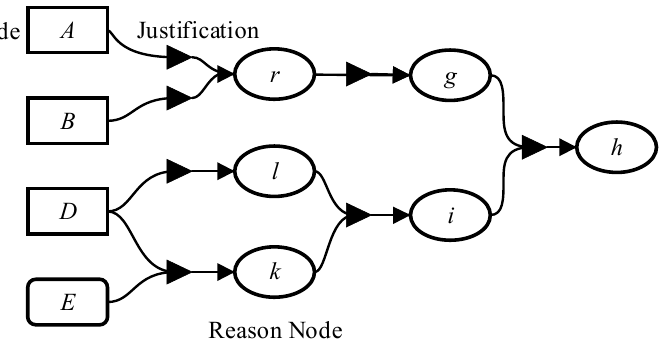
Figure 6. Logic based Truth Maintenance System (LTMS).